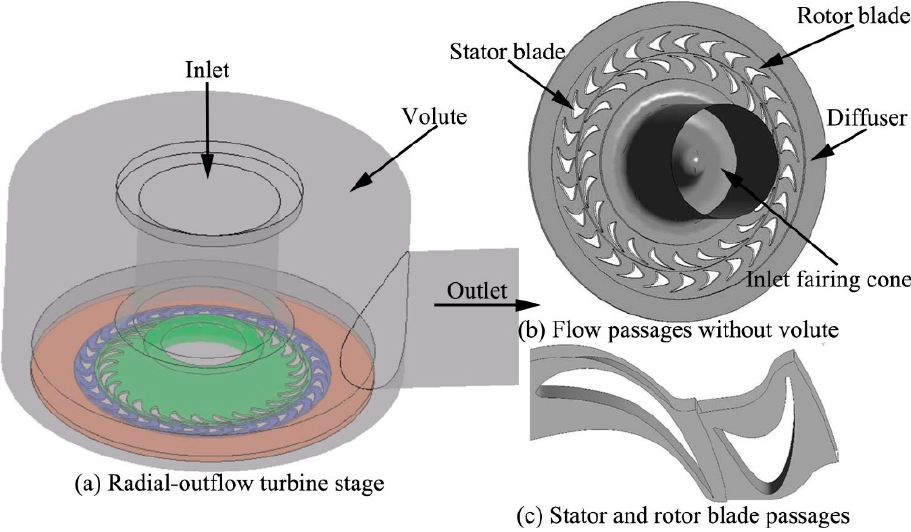
Figure 2. Physical model of radial-outflow turbine.